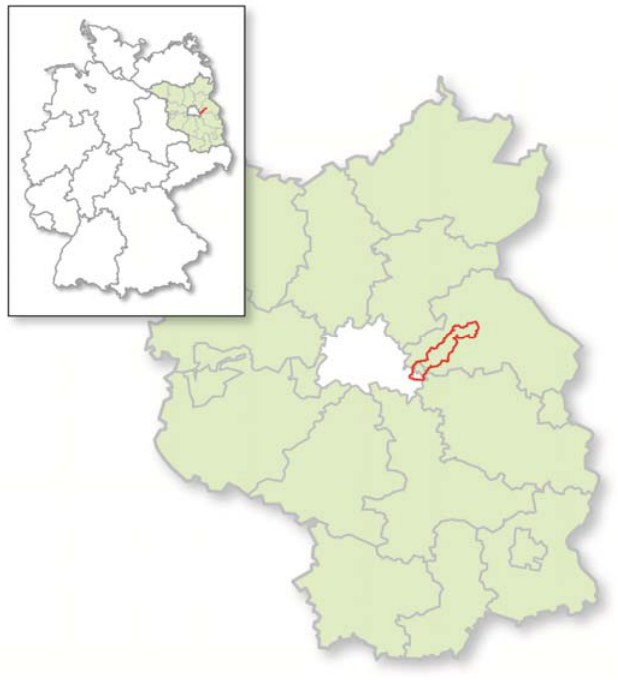
Figure 1. The location of the Berlin-Brandenburg region in Germany and of the Fredersdorf Mill Stream catchment in the